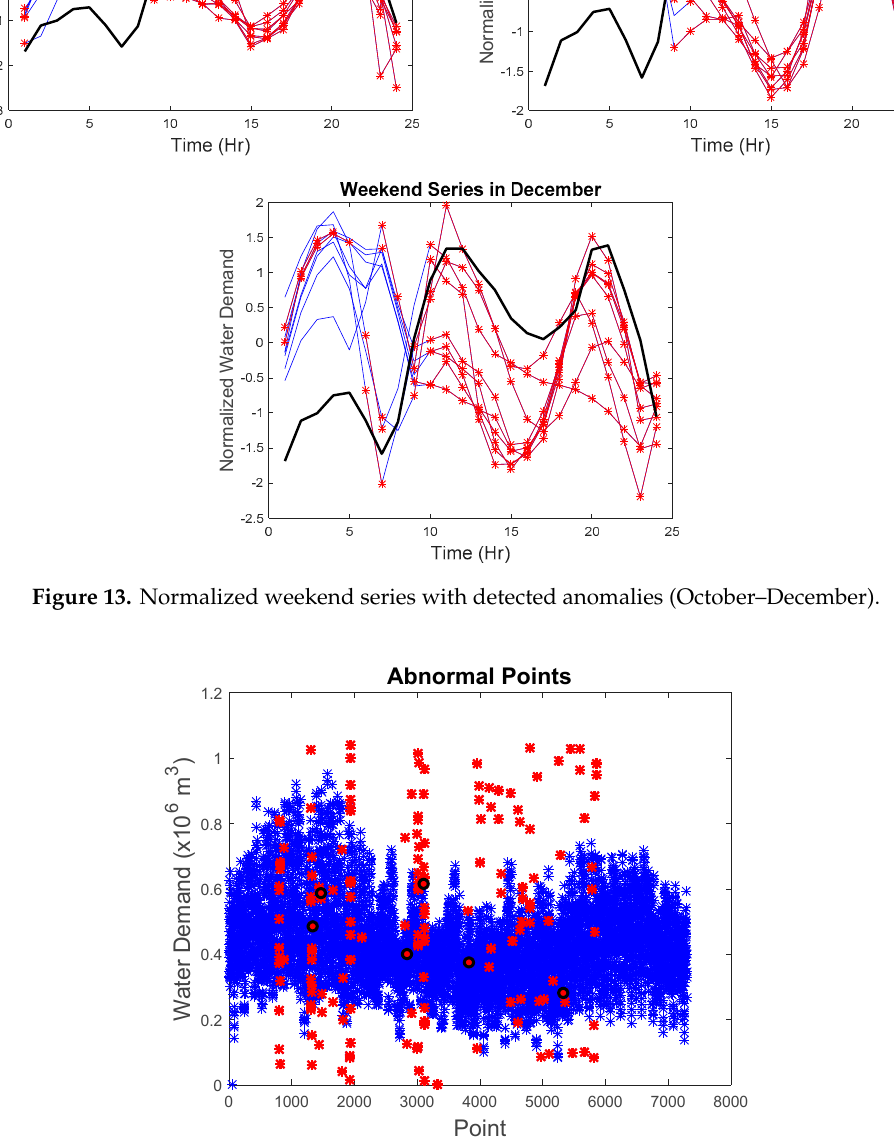
Figure 14. Original data points (blue star) with imputed anomalies (red star) and missed detection (black circle).